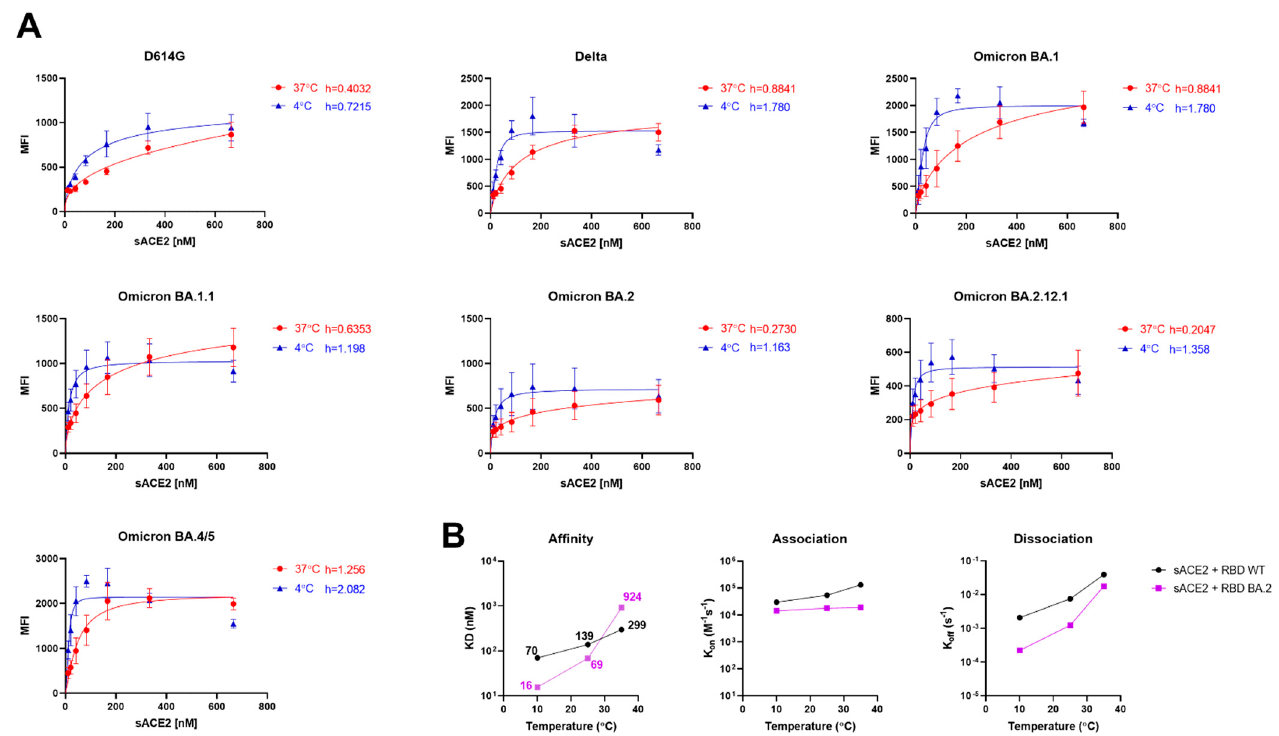
Figure 2. Low temperatures “open” Omicron subvariant Spikes. ( A ) The binding of sACE2 to the Spike of D614G, Delta, Omicron BA.1, BA.1.1, BA.2, BA.2.12.1, BA.4/5 expressed on the surface of 293T cells was measured by flow cytometry. Increasing concentrations of sACE2 were incubated with Spike-expressing cells in 4 ◦ C (blue) or 37 ◦ C (red). Means ± SEM derived from at least three independent experiments are shown. The Hill coefficients were calculated using GraphPad software. ( B ) Binding kinetics between SARS-CoV-2 RBD (WT or BA.2) and sACE2 assessed by biolayer interferometry at different temperatures. Graphs represent the affinity constants (K D ), on rates (K on ), and off rates (K off ) values obtained at different temperatures and calculated using a 1:1 binding model. Raw data and fitting models are presented in Figure S2.